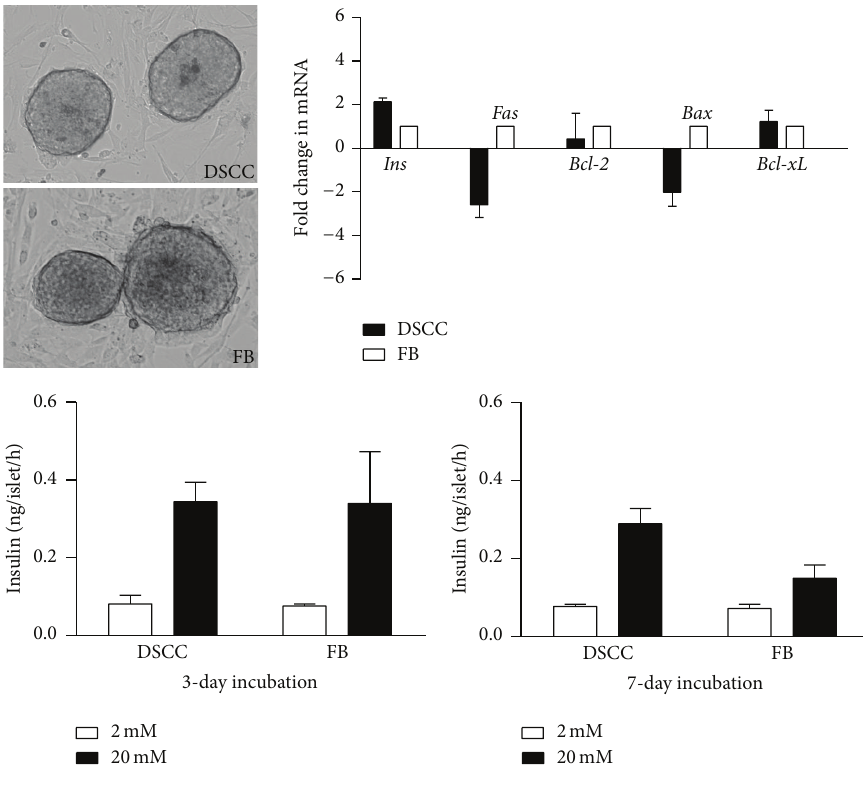
Figure 1: DSCC stimulates reduced alloimmune responses and promotes beta cell survival in vitro . (a) Immune privilege related genes were expressed in DSCC. Hair follicle dermal sheath cup cells (DSCC), dermal papilla (DP), and dermal sheath (DS) cell gene expression were